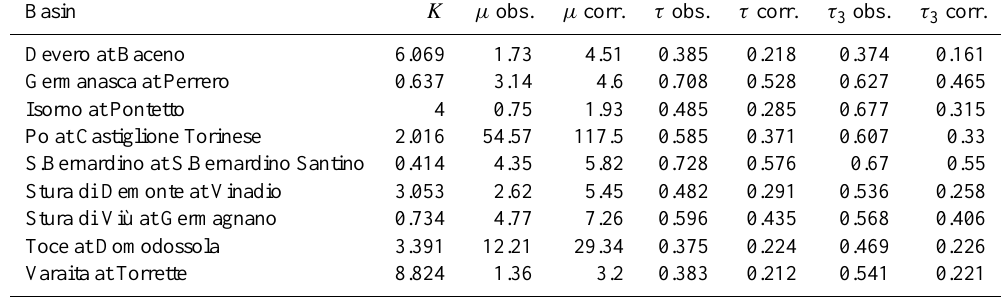
Table 1. Observed and corrected L -moments for gauging stations affected by relevant water intakes. Basin K µ obs. µ corr. τ obs. τ corr. τ 3 obs. τ 3 corr.